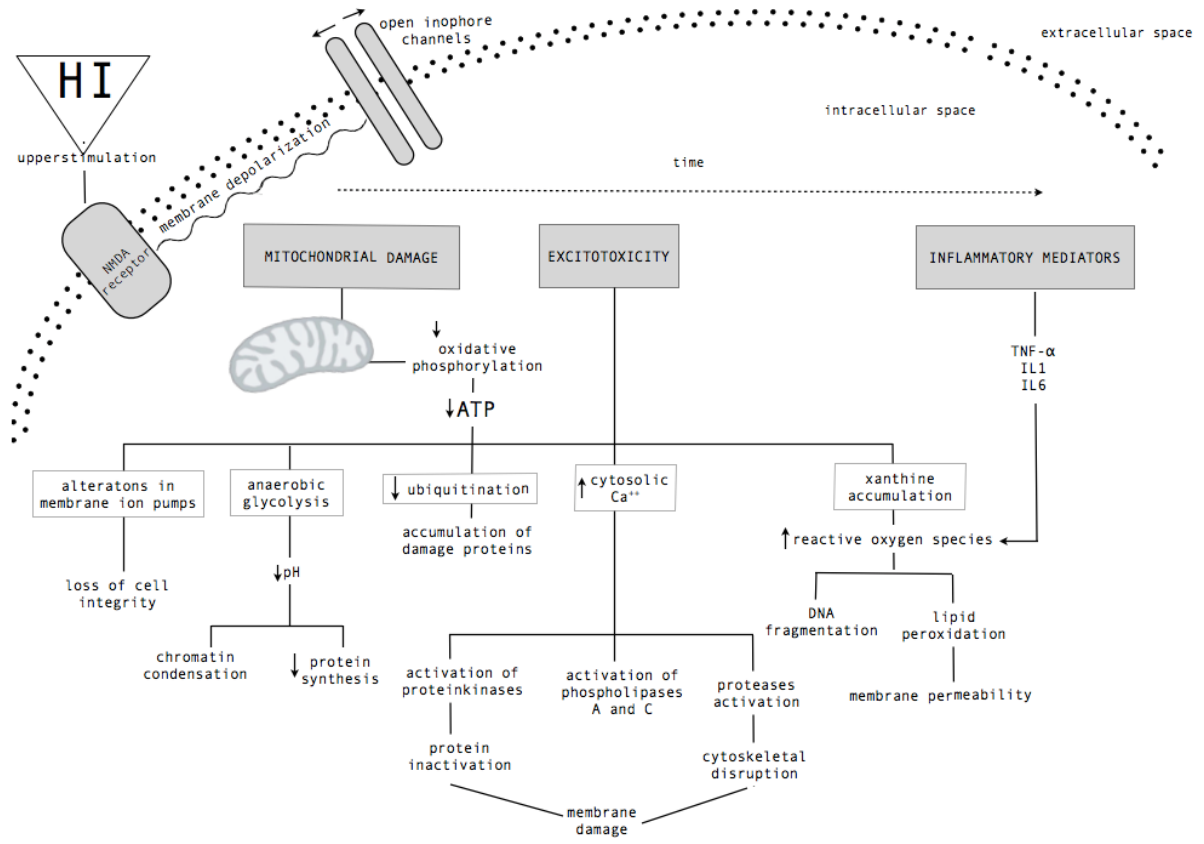
Figure 1. Cascade of biochemical mechanism after hypoxic-ischemic (HI) brain injury. A schematic diagram that summarizes the cellular and molecular events triggered after HI injury in the developing brain. Mitochondrial damage, the cytotoxic levels of intracellular calcium and the release of inflammatory mediators cause metabolic failure, oxidative stress and ultimately the cell